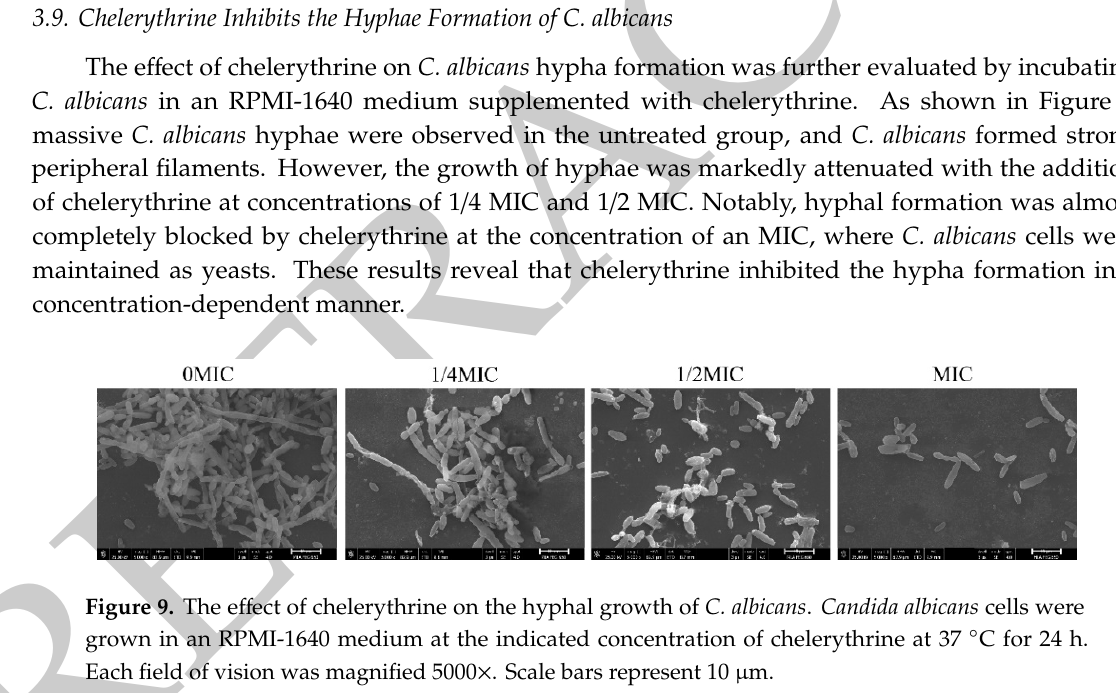
Figure 8. Scanning electron microscopy images of C. albicans (CA) and S. aureus (SA) mono- and dual-species (SA + CA) mature biofilms after treatment with four MIC-fold concentrations of chelerythrine. Each field of vision was magnified 10,000 × . Scale bars represent 5 µ m.